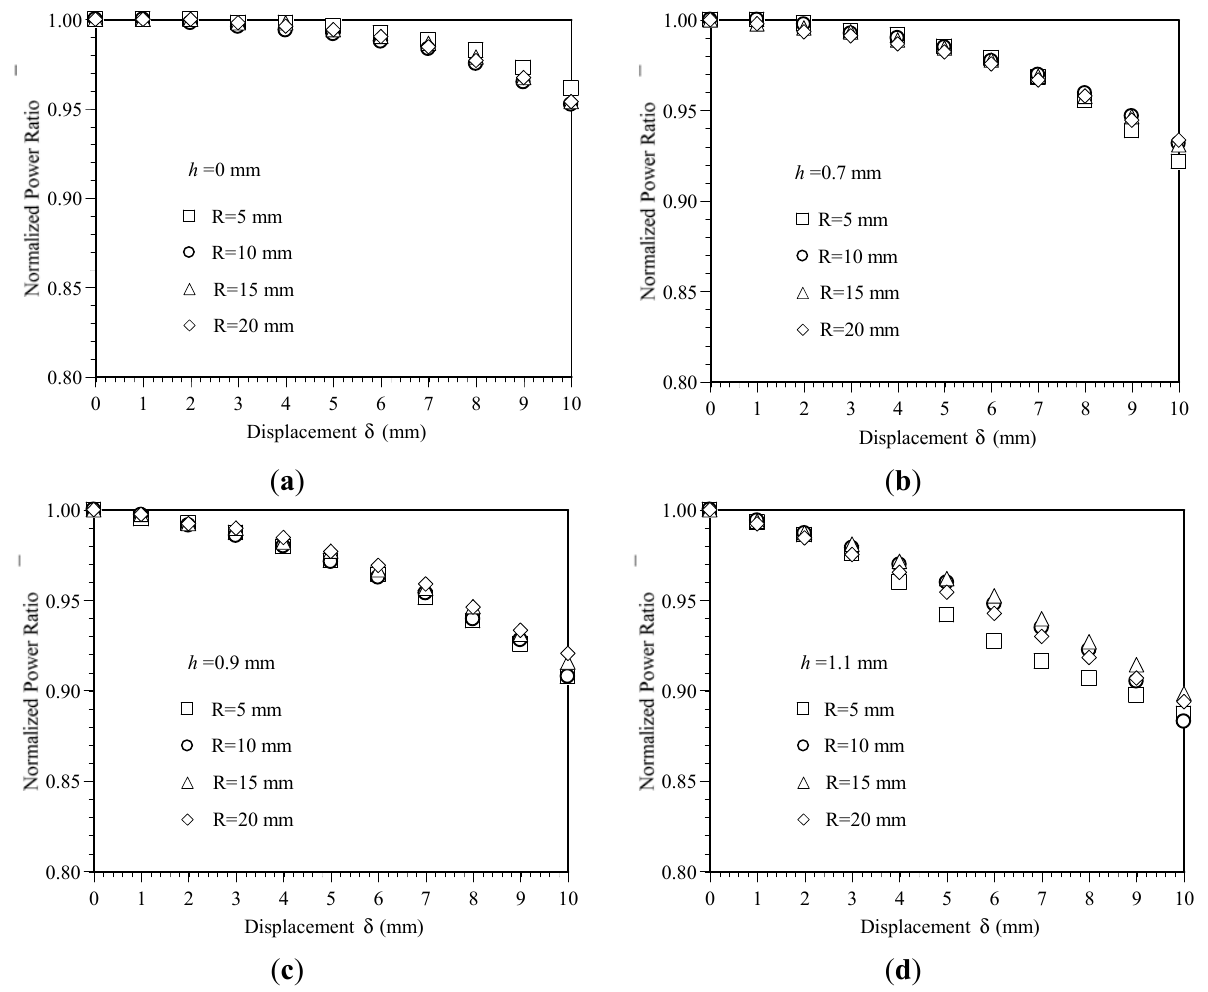
Figure 4. Variation of normalized power ratio (cid:2015)(cid:1191) with displacement δ as function of disc radius R given groove depths of: ( a ) h = 0 mm. ( b ) h = 0.7 mm. ( c ) h = 0.9 mm. ( d ) h = 1.1